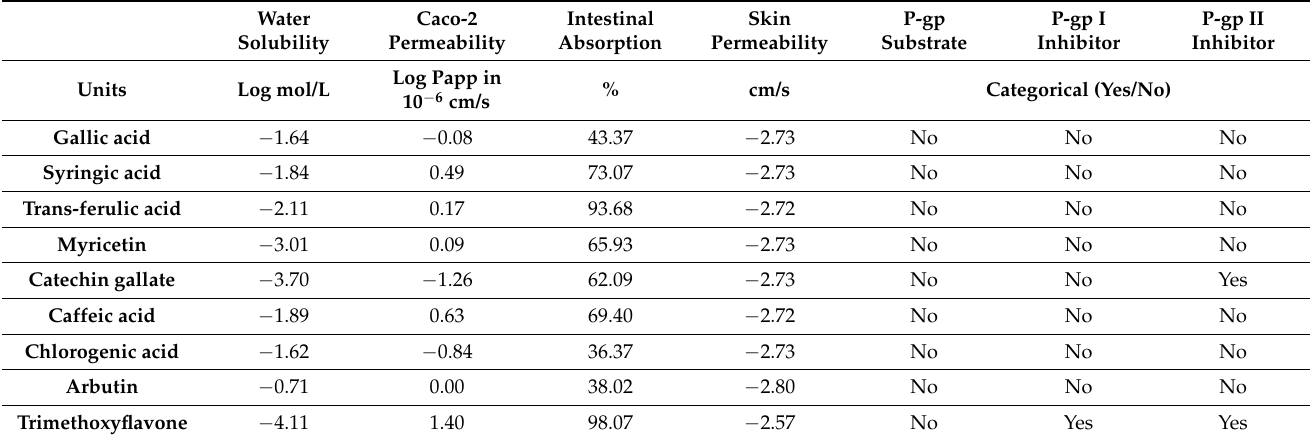
Table 3. Absorption prediction of A. halimus leaf ethanolic